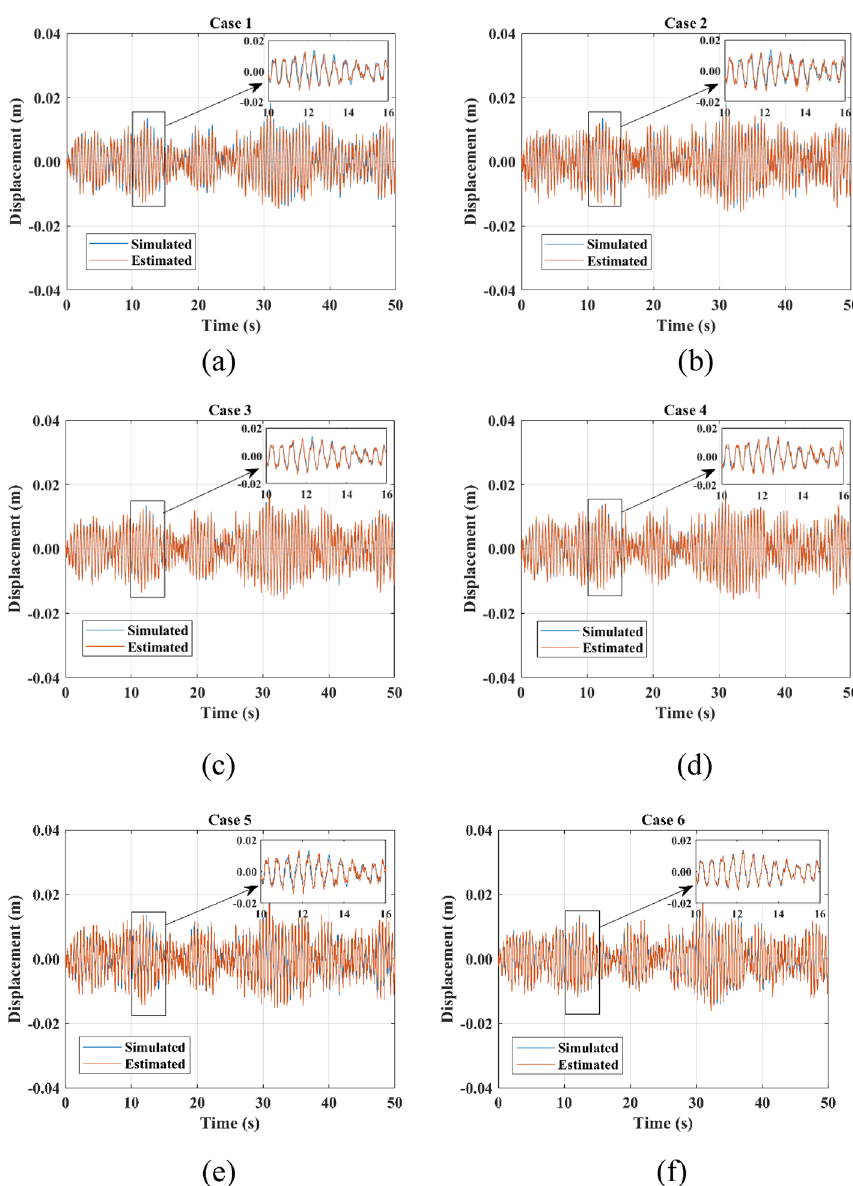
Fig. 5 Displacement estimation of a SDOF system under different cases